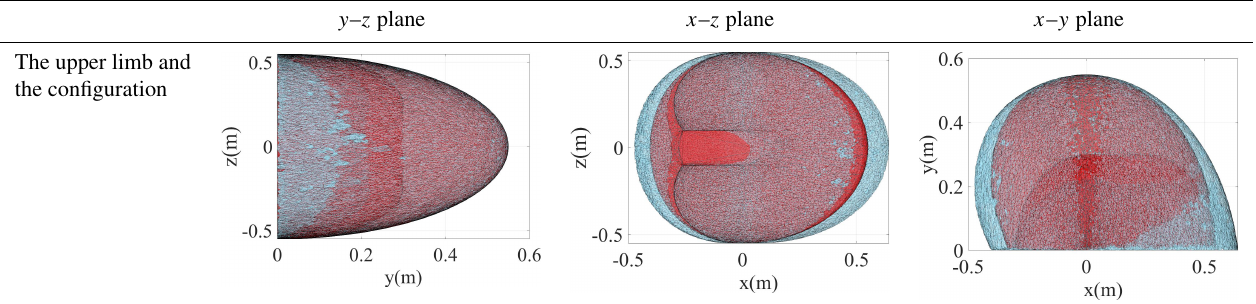
Table 6. The workspace of the upper limb and the two configurations.